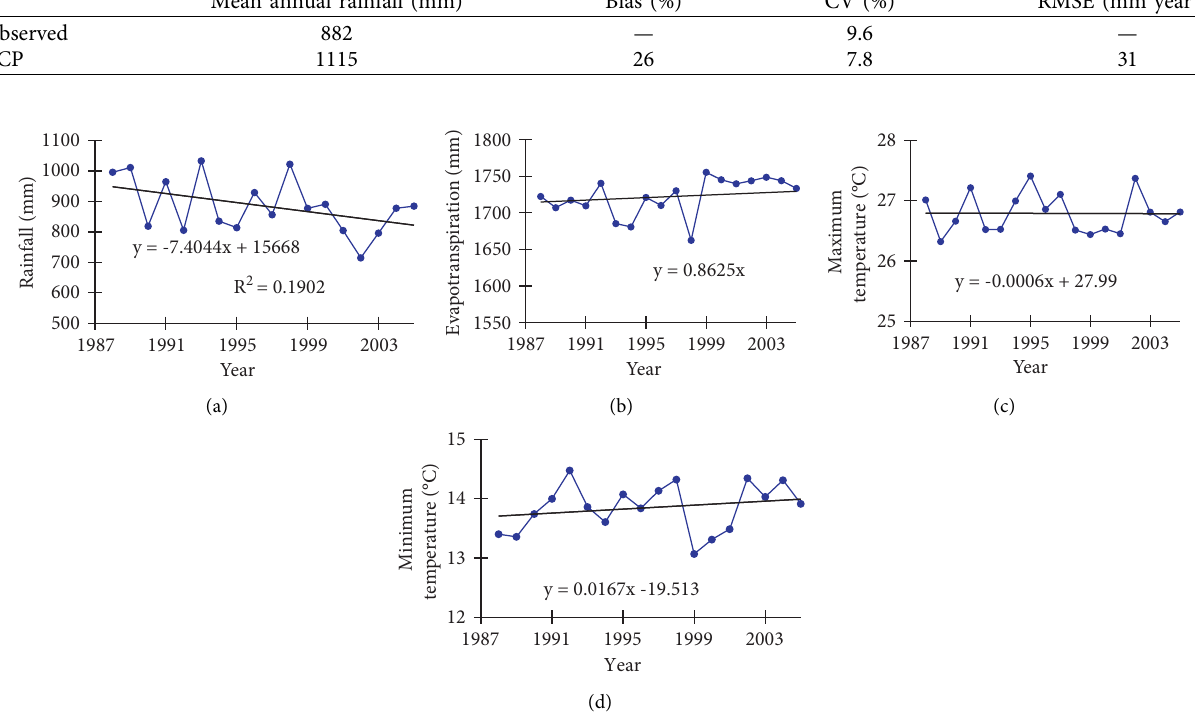
Figure 3: Trends in historical climatic: (a) rainfall, (b) evapotranspiration, (c) maximum temperature, and (d) minimum temperature data. Bias correction of precipitation and temperature data.